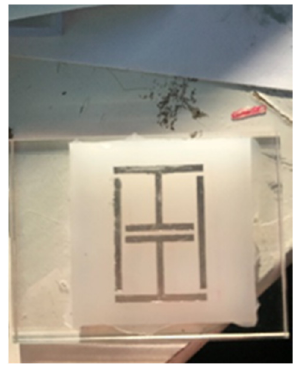
Figure 5. EDM latex tag on copper sheet.